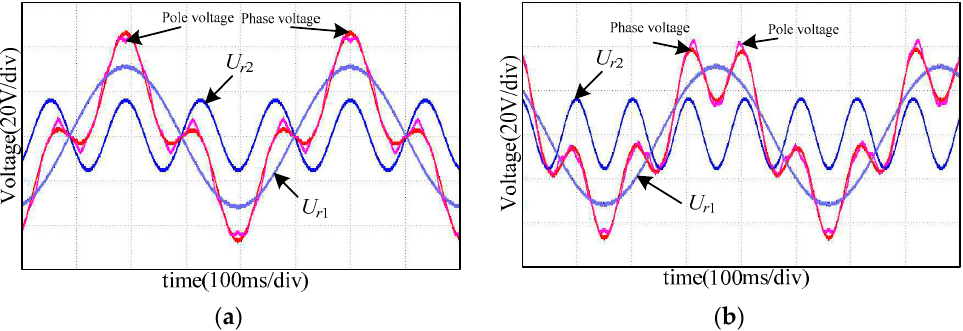
Figure 17. Experimental results of DFV − SVPWM with different frequencies: ( a ) θ 2 = 3 θ 1 ; ( b ) θ 2 = 4 θ 1 .